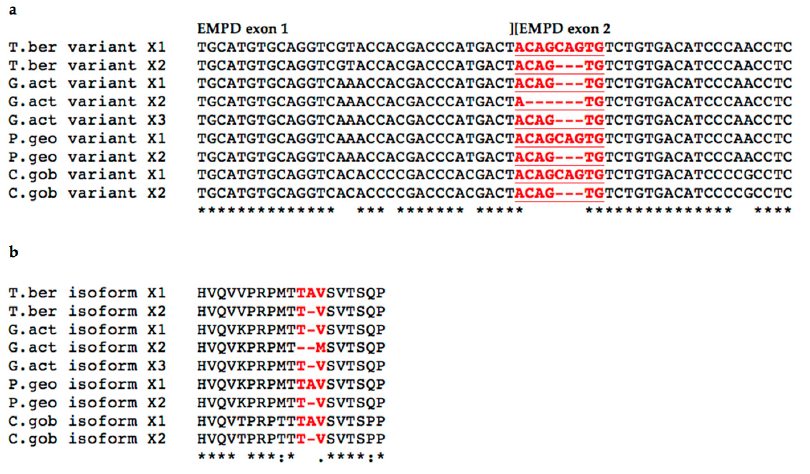
Figure 6. Multiple alignments of the EMPD sequences. ( a ) Multiple alignment of cDNA sequences spanning the two EMPD exons of the pIgR variants identified in the Antarctic species T. bernacchii (T.ber variants X1 and X2), G. acuticeps (G.act variants X1, X2, and X3), P. georgianus (P.geo variants X1 and X2), and in the non-Antarctic species C. gobio (C.gob variants X1 and X2). The exonic region in which a cryptic splicing site was predicted is depicted in bold red and underlined; ( b ) multiple alignment of deduced amino acid residues of the EMPD domain. Amino acid residues involved in the usage of the cryptic splice site are depicted in bold red. Gaps are indicated by dashes. Identical nucleotides or amino acid residues are marked with an asterisk below alignments; positions differing in one nucleotide or amino acid residue are marked with a dot. As previously shown by the AT content analysis of notothenioid IgT genes [21], a remarkably high AT content of pIgR exons was shared within Antarctic species, reaching a peak (55.8%) in the Nototheniidae family, which comprises T. bernacchii and Dissostichus eleginoides (Figure 7). This finding reflects a peculiar feature not shared with either the non-Antarctic species C. gobio , their closest relative, or all the other Perciformes. Figure 7. Percentage of AT content of the pIgR exons of Antarctic species (blue bars) and the non- Antarctic notothenioid species C. gobio (light blue bar) compared to representative species of the